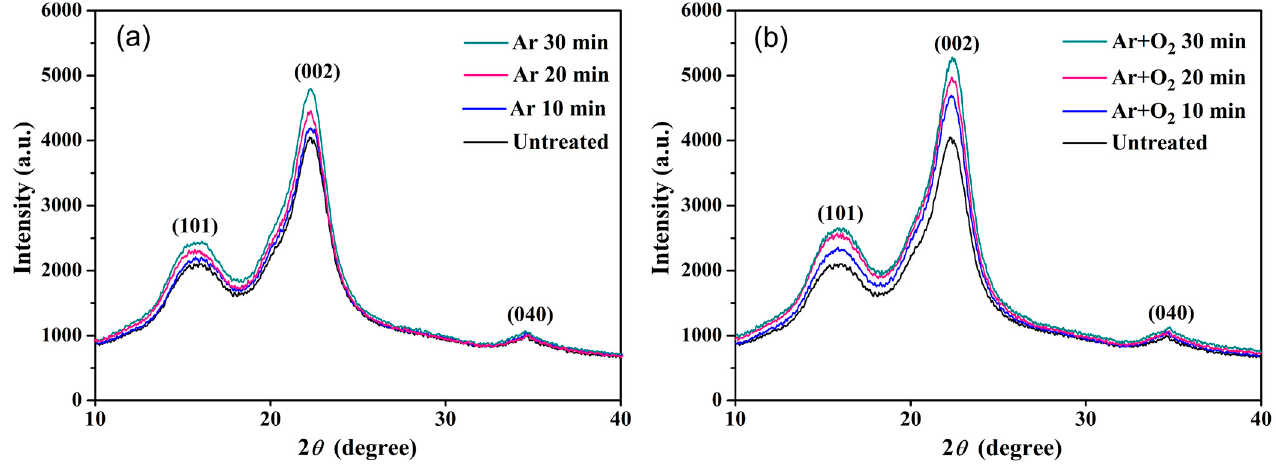
Figure 6. XRD diffractograms of untreated and treated BFs with ( a ) Ar gas and ( b ) Ar + O 2 gas for various treatment times.